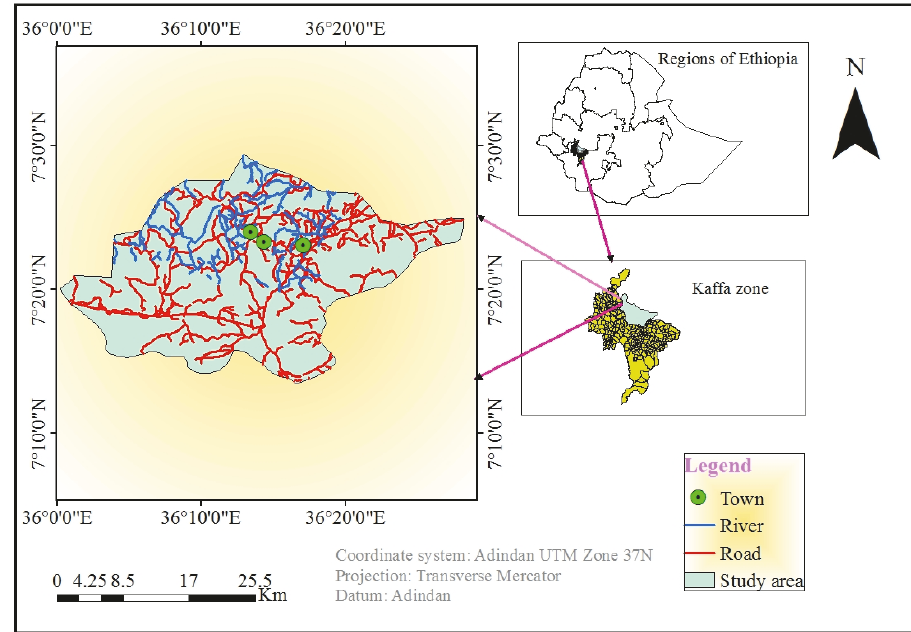
Figure 1: Map of the study